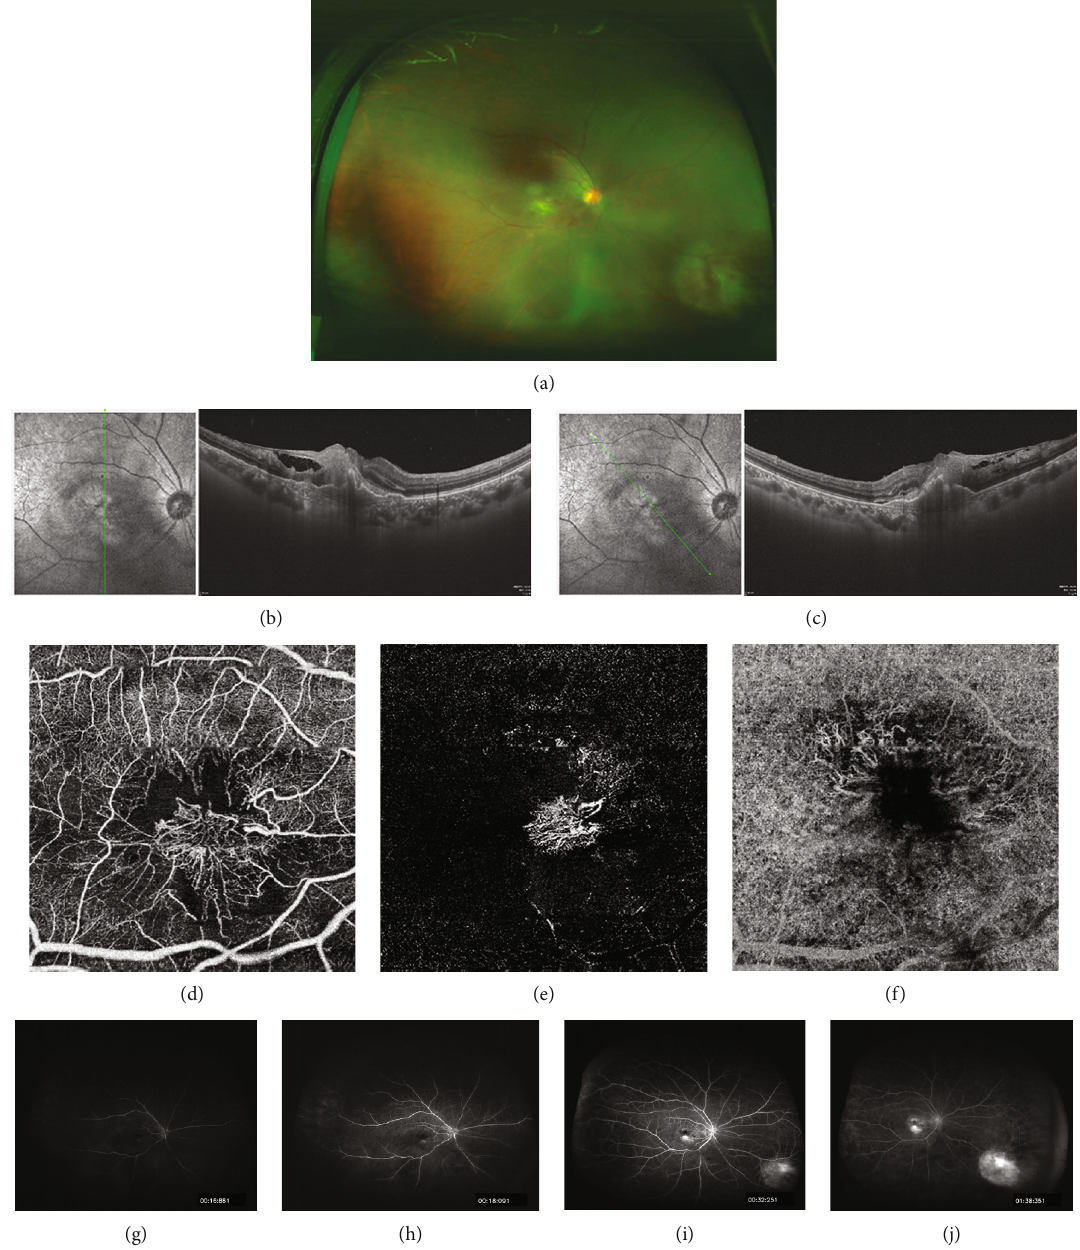
Figure 2: Infectious chorioretinitis and RAP were identi fi ed in the right eye. (a) The crooked retinal arterioles and retinal venules extend into deeper layers in the macula. (b, c) OCT showed a thickened epiretinal membrane, hyperre fl ective material located at the level of the outer retinal layers, and vascularized PED in macular fovea of the right eye. (d – f) OCTA detected abnormal vascular networks in the super fi cial retinal capillary plexus (d), deep retinal capillary plexus (e), and choroid layers (f). (g – j) Fundus fl uorescein angiography (FFA) of the patient: (g) a central, intraretinal hyper fl uorescent lesion was visible, which is probably fed by the retinal arteriolar vessel at 2 o ’ clock; (h) progressive fi lling of the venous circulation, connected to the hyper fl uorescent lesion; (i) the central, intraretinal vascular complex was clearly recognizable in macular, and a round hyper fl uorescent lesion was detected at inferonasal peripheral retina; (j) leakage of fl uorescent dye from the vascular complex, abnormal dilation of the capillaries, and the hyper fl uorescent